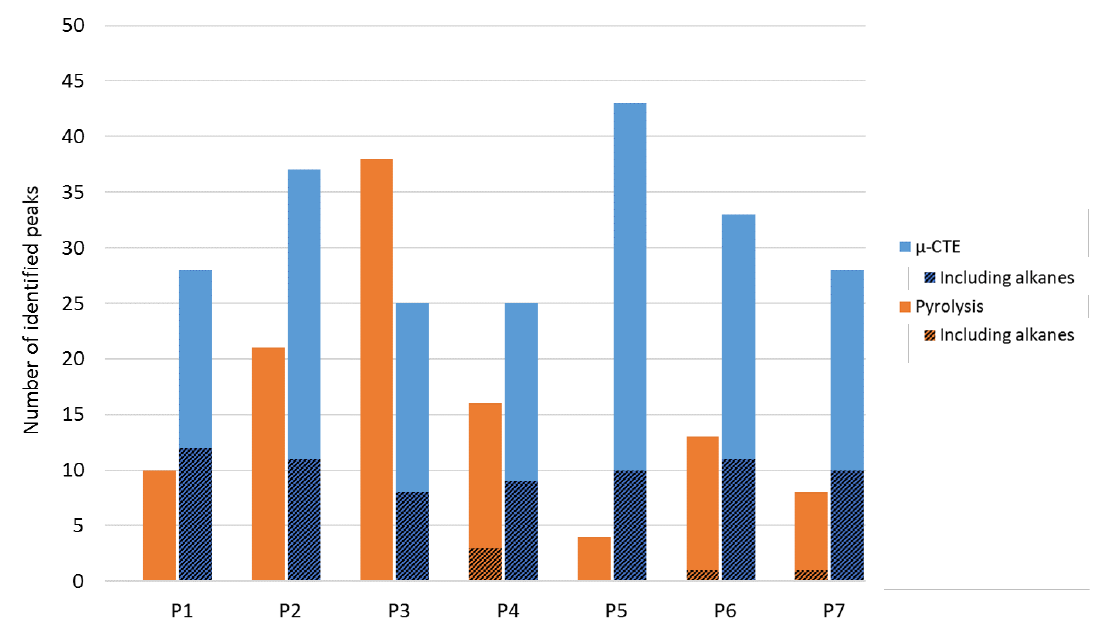
Figure 3. Number of peaks identified in every sample by Pyr (orange) and SPME-µCTE (blue), including alkanes (striped).